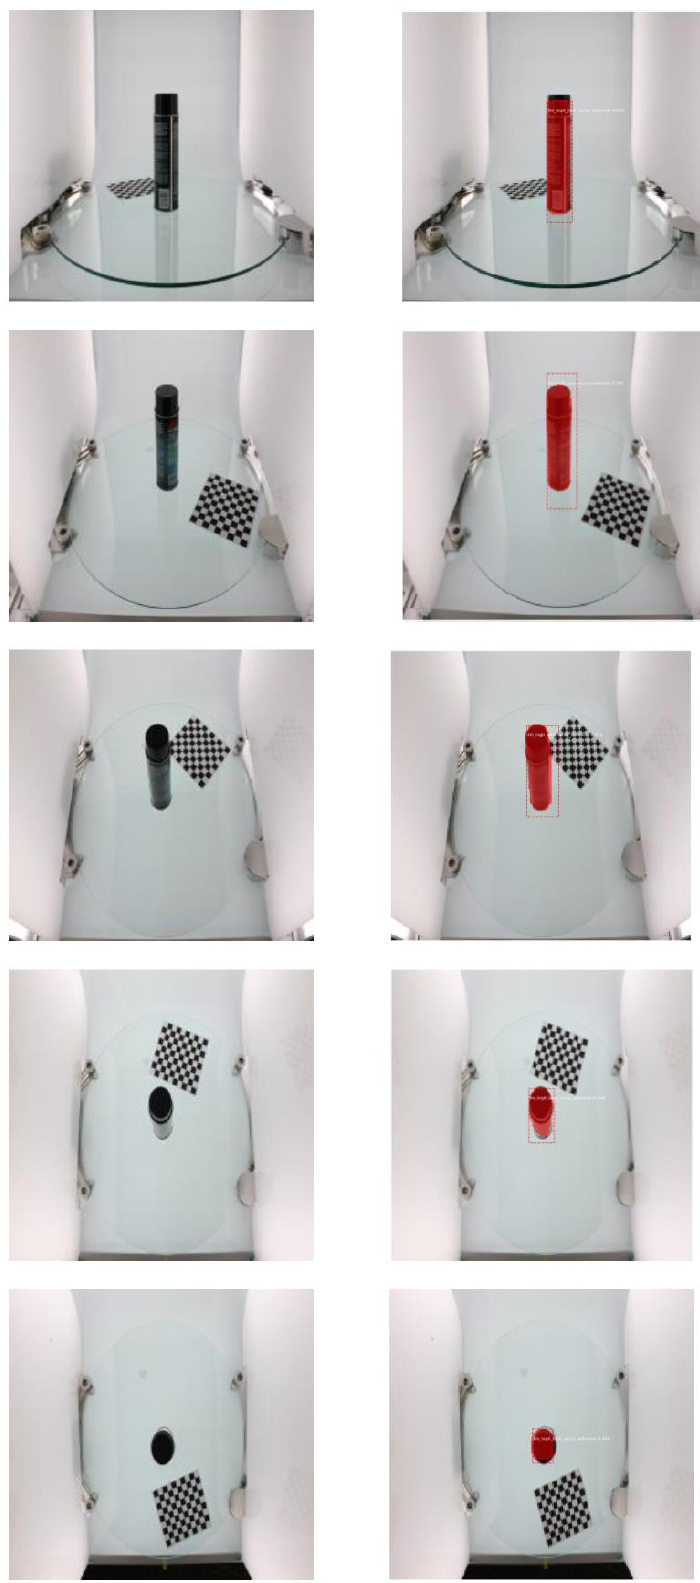
Figure 14. Results for 3 m_high_tack_spray_adhesive data using the Mask R-CNN-based object detection method. The column on the left contains the input images. The column on the right shows the positioning and segmentation